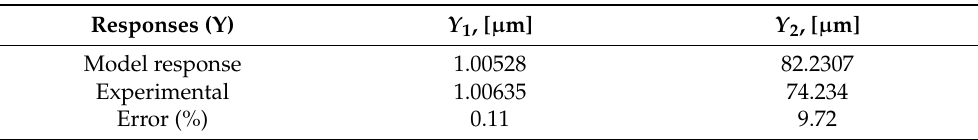
3.90 Figure 18. Hole diameter errors between stack-up materials for all runs.